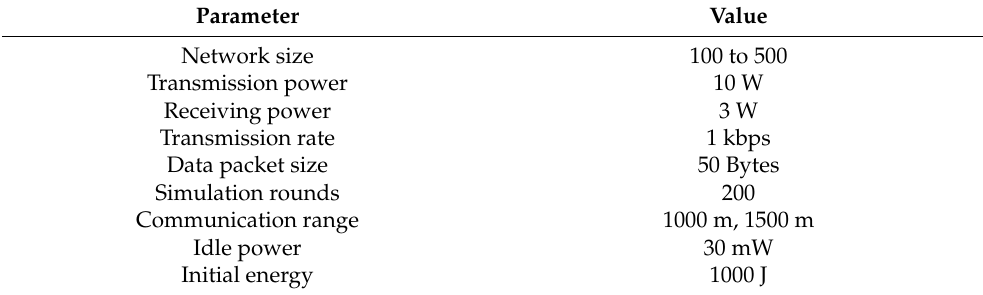
Table 2. Simulation